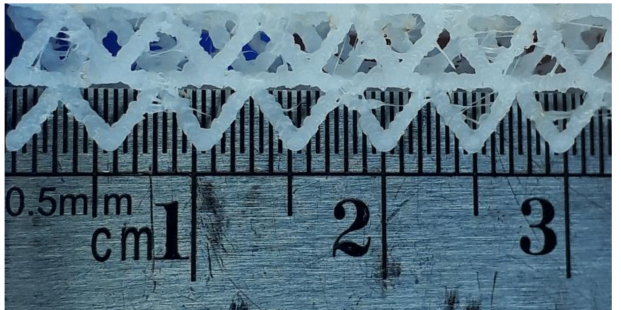
Figure 11. Multiple adjacent struts (lattice structure 1, ABS, Up mini 2, scale 1:1). Nominal strut thickness 0.7 mm. Effective strut thickness 0.89 ± 0.06 mm.